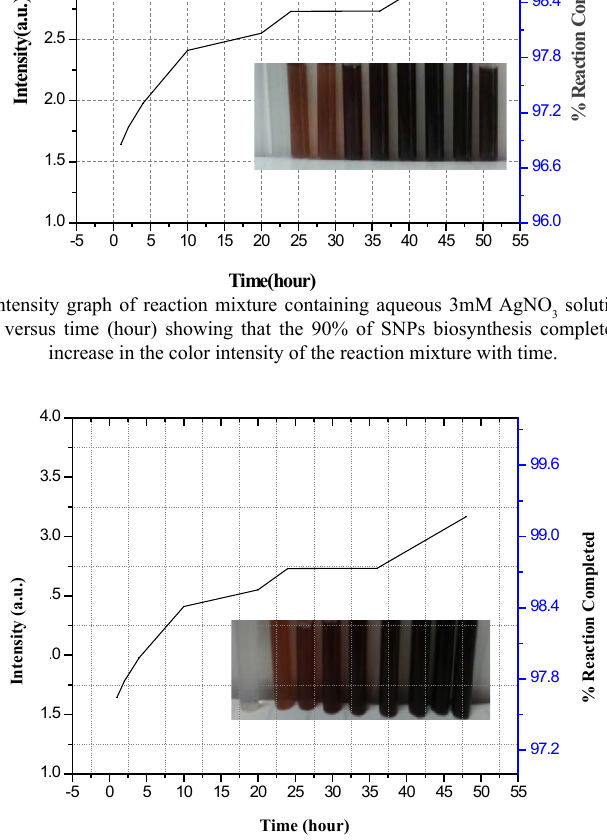
Fig.1. (b): RAgNPs: Intensity graph of reaction mixture containing aqueous 3mM AgNO solution treated Root Water 3 extract (RWE) versus time (hour) showing that the 90% of NPs biosynthesis completed within 2 hr. Inset: increase in the color intensity of the reaction mixture with